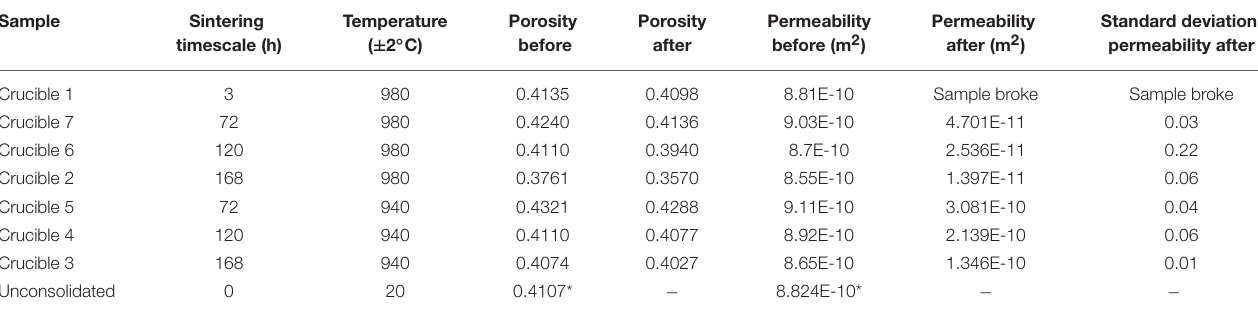
TABLE 3 | Measurements of physical properties of synthetic samples: Porosity by He-pycometry for crucibles (35mm diameter) filled to 50mm with crushed and sieved andesite before and after sintering at a range of timescales (accurate to the nearest minute) and temperatures, as well as corresponding permeability measurements using a TinyPerm II minipermeameter.